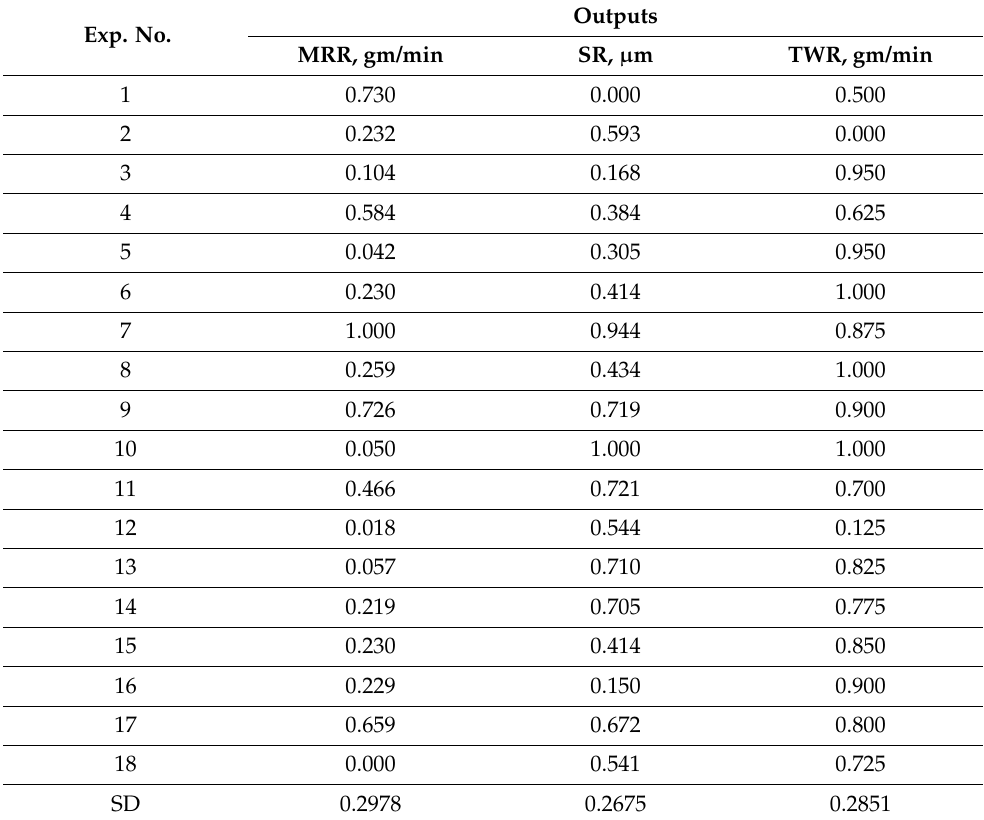
Table 12. Normalized values of responses—criteria importance through criteria inter-correlation (CRITIC) method. Outputs Exp. No. MRR, gm/min SR, µ m TWR,